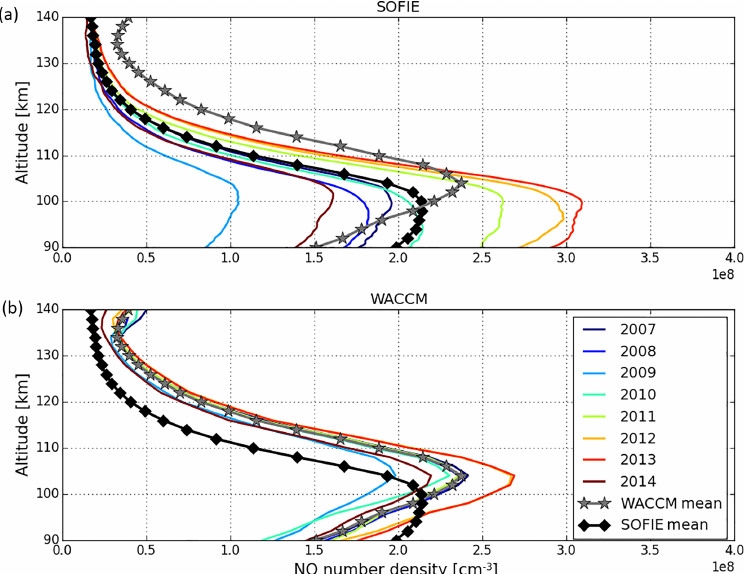
Figure 6. Inter-annual variability of the mean SH winter profile for SOFIE (a) and WACCM (b) . A multi-year mean winter profile for SOFIE (black diamonds) and WACCM (grey stars) is given in each